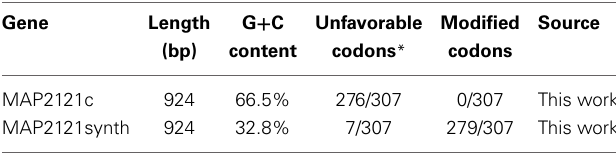
Table 2 | Modification and codon optimization of MAP